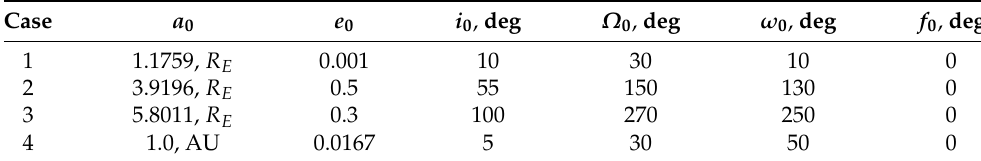
Table 1. Parameters for initial orbital elements.